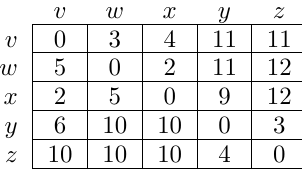
Figure 15. Transition costs between conventions. For transitions between conventions in the set v , w , x , y , z , the table gives the cost of a transition from the convention specified by the row to the { } convention specified by the column. For example, a transition from v to x has a cost of 4.